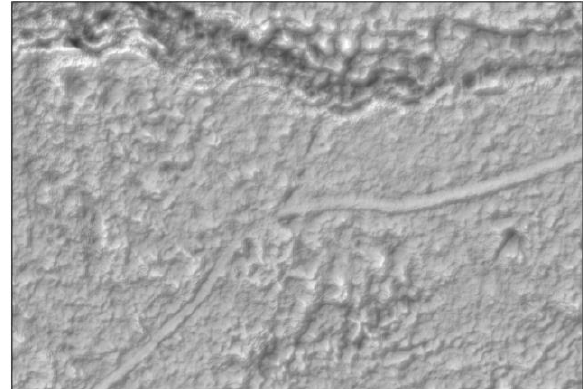
Figure 15. Sermermiut old settlement – orthophoto superimposition with map from Ilulissat museum, (Pavelka, Šedina, 2015)